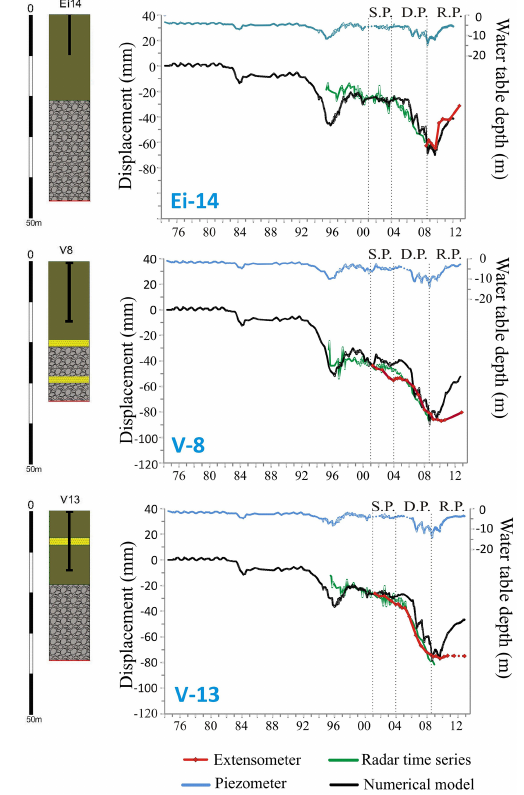
Figure 3. Modelled columns (clay: brown, sand: yellow, gravel: grey); computed and measured subsidence time series (exten- someters and Radar); piezometric time series. (S.P.: stable period; D.P.: drought period; R.P.: recovery), redrawn after Tessitore et al. (2015).